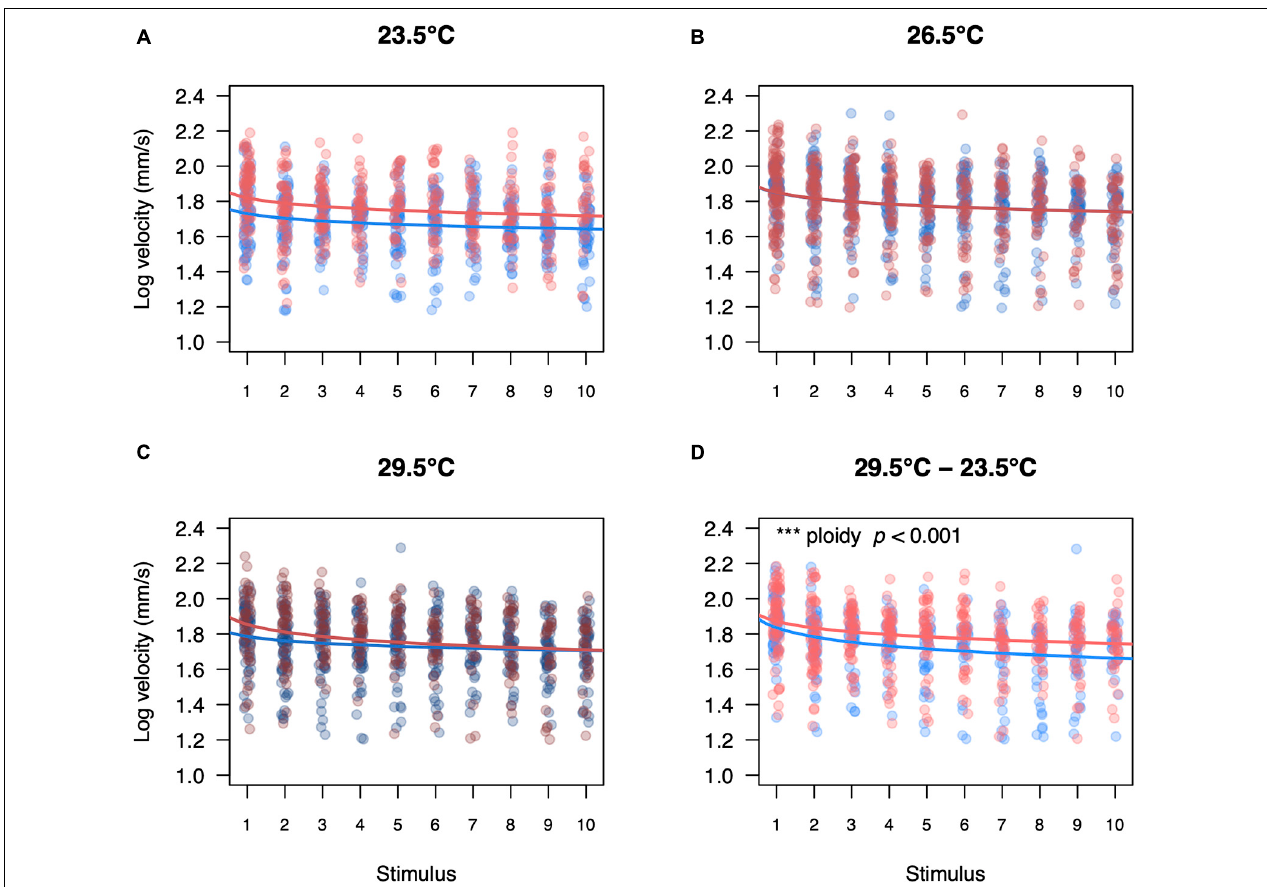
FIGURE 7 | Swimming velocity of diploid and triploid responders for each startle stimulus per temperature treatment. Swimming velocity of diploid and triploid larvae reared and measured at 23.5 ◦ C (A) , 26.5 ◦ C (B) , 29.5 ◦ C (C) or reared at 29.5 ◦ C and measured at 23.5 ◦ C (D) . Each value represents an individual larva that responded to the startle stimulus, where blue points represent diploid larvae and red points represent triploid larvae. Over all the effects of ploidy level (ANOVA, p < 0.05), temperature treatment (ANOVA, p < 0.05), stimulus number (ANOVA, p < 0.001), and length (ANOVA, p < 0.001) were significant. The effect of ploidy was also analyzed for a subset of each temperature treatment, comparing a model with and without ploidy level included. Ploidy was significant for larvae reared at 29.5 ◦ C and measured at 23.5 ◦ C ( p < 0.001, n =